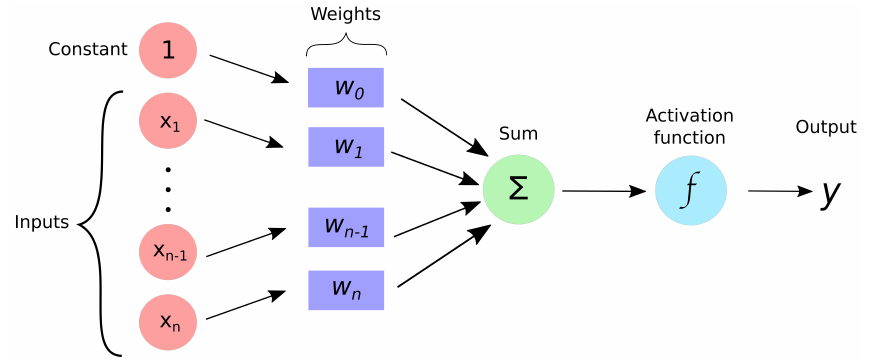
Figure 7. The Perceptron model.